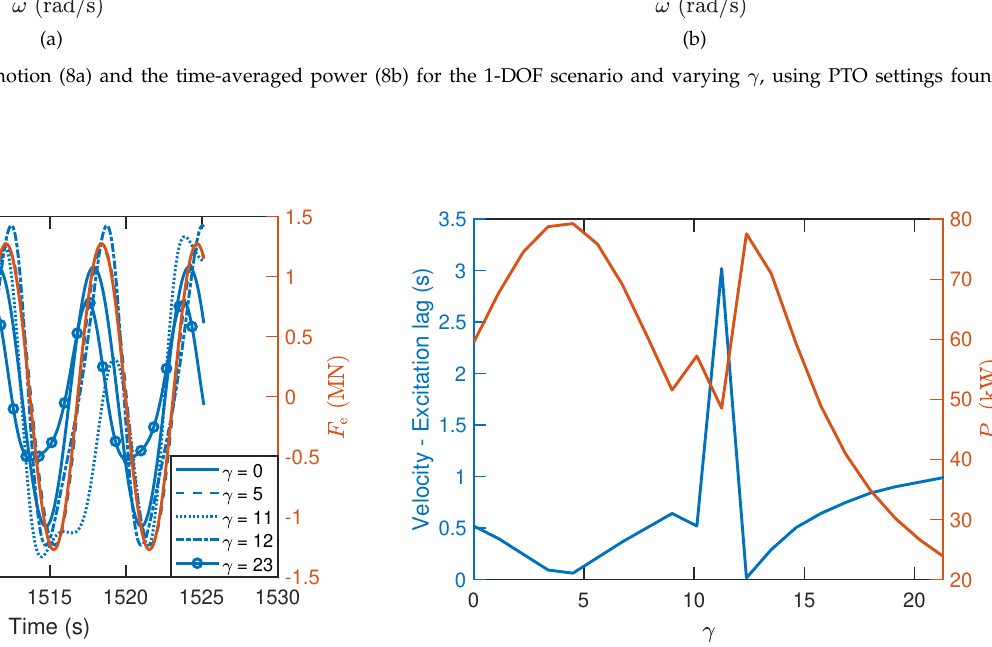
Fig. 10. The phase lag between the excitation force and velocity when excited at ω = 1 rad / s for varying γ with the non-optimized PTO